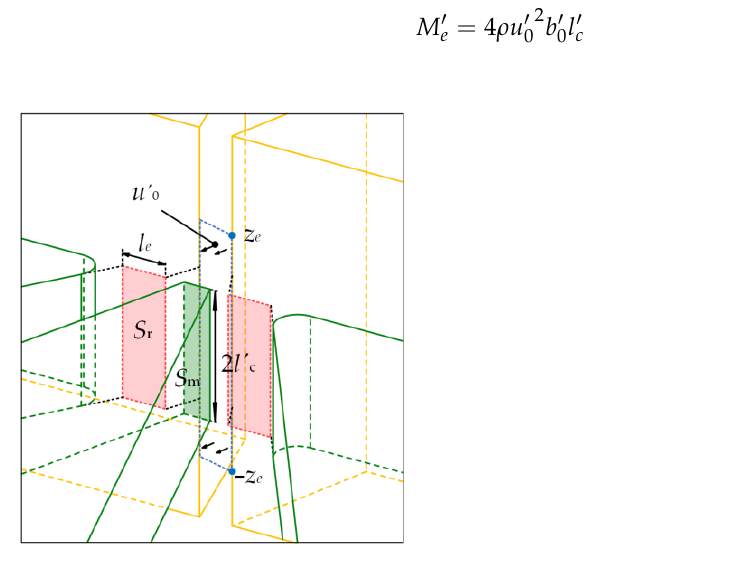
Figure 6. Solid impact surface and effective impact area. Simulation results [24] show that each receiver has a fluid surface to sustain the jet impact, which is referred to as the effective impact area. Approximately, the pressure in this area is uniform and equal to the pressure in the